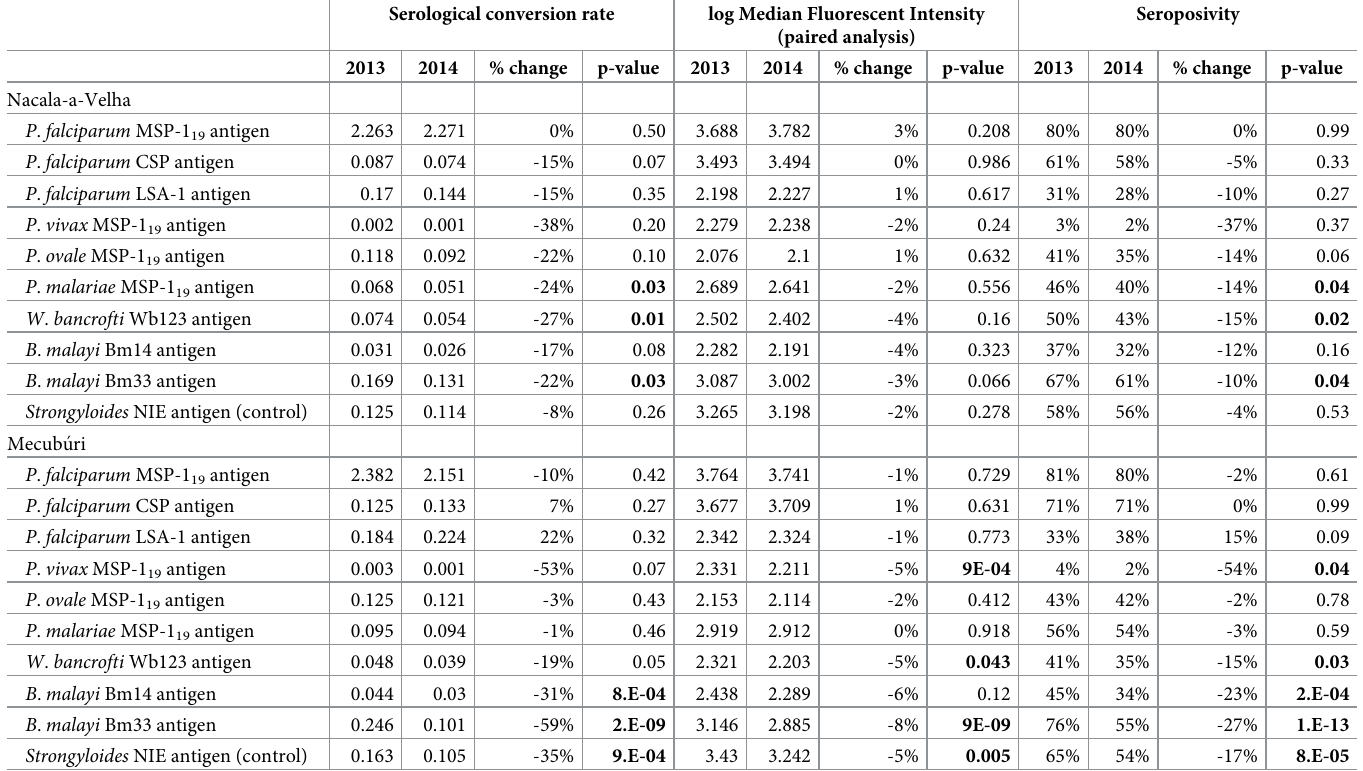
Table 4. Change in serological indicators of malaria and lymphatic filariasis exposure immediately following and one year after an LLIN distribution campaign in Nacala-a-Velha and Mecubu´ri Districts,